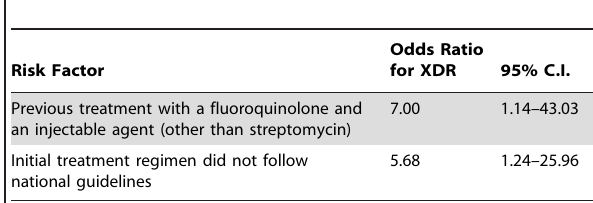
Table 4. Multivariate Analysis: Risk factors for XDR.